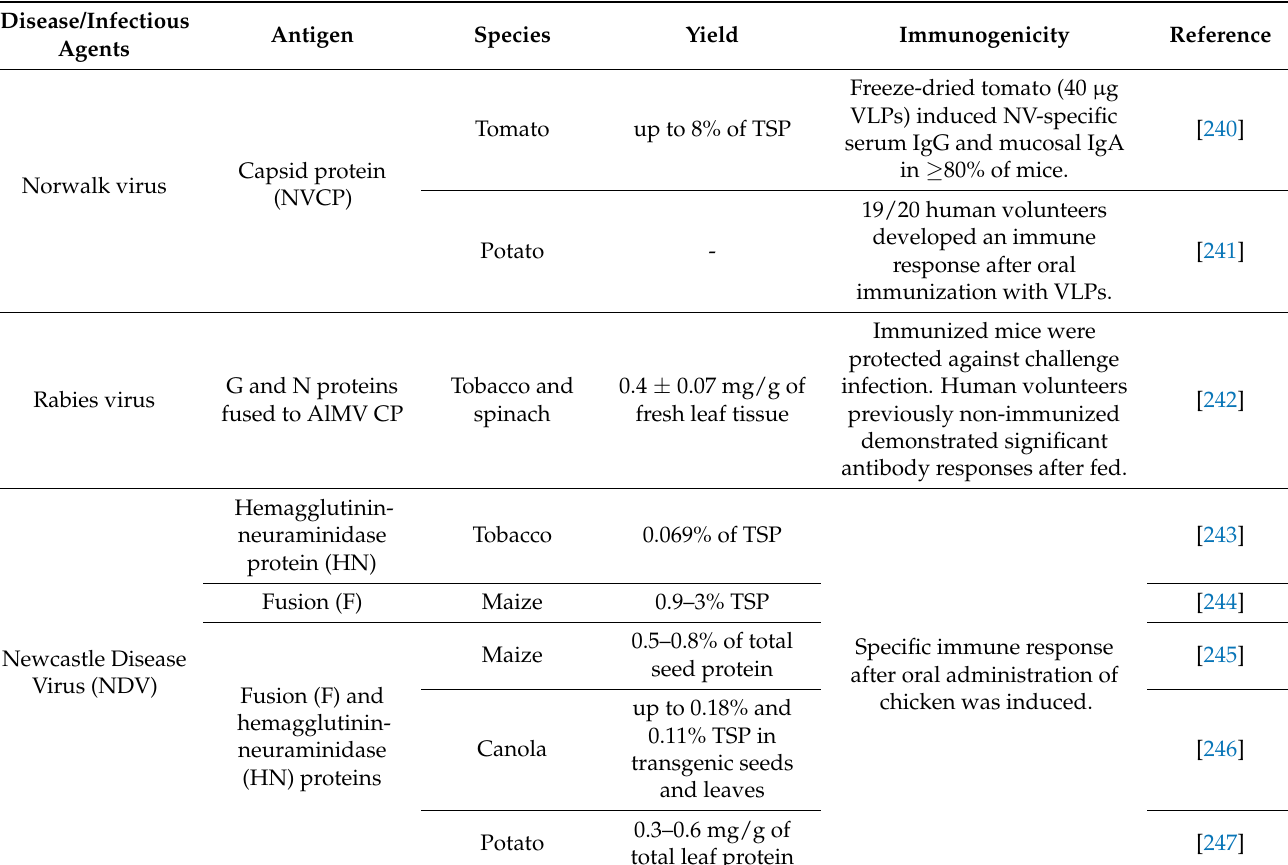
Table 2. List of known to be edible vaccines against animal pathogens.